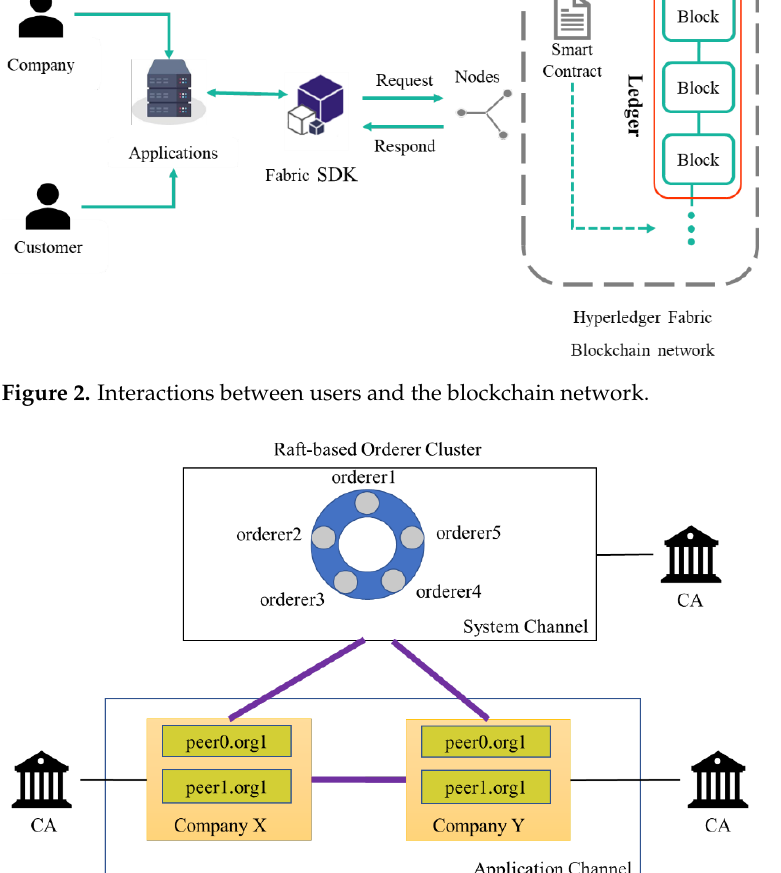
( b ) Figure 4. User interface of registration. B.